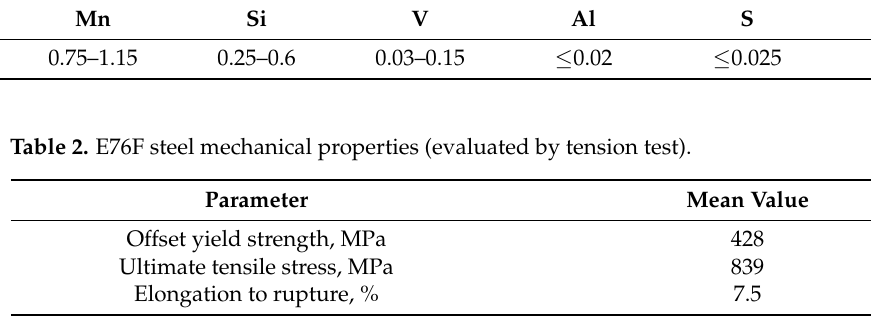
Table 1. E76F steel chemical composition (reference data).